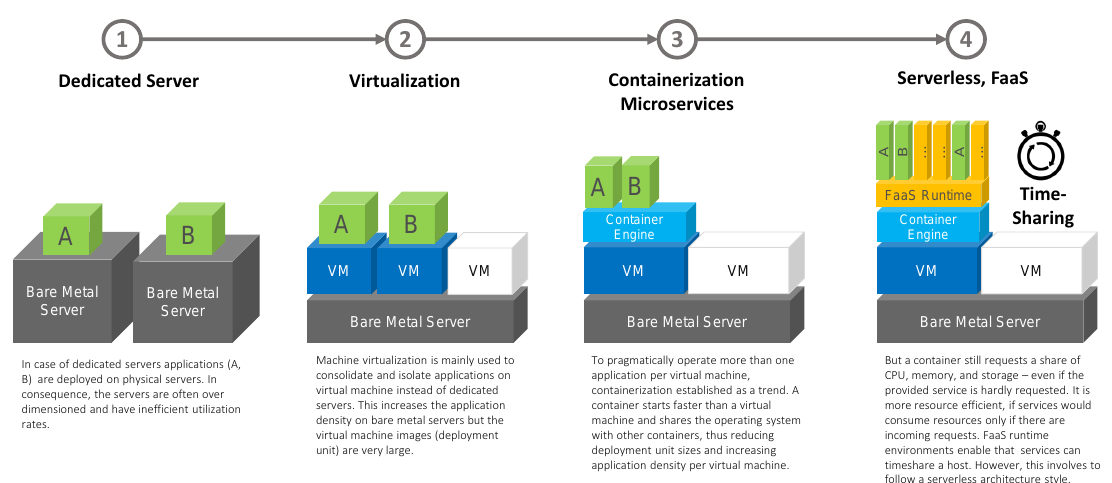
Figure 4. The cloud architectural evolution from a resource utilization point of